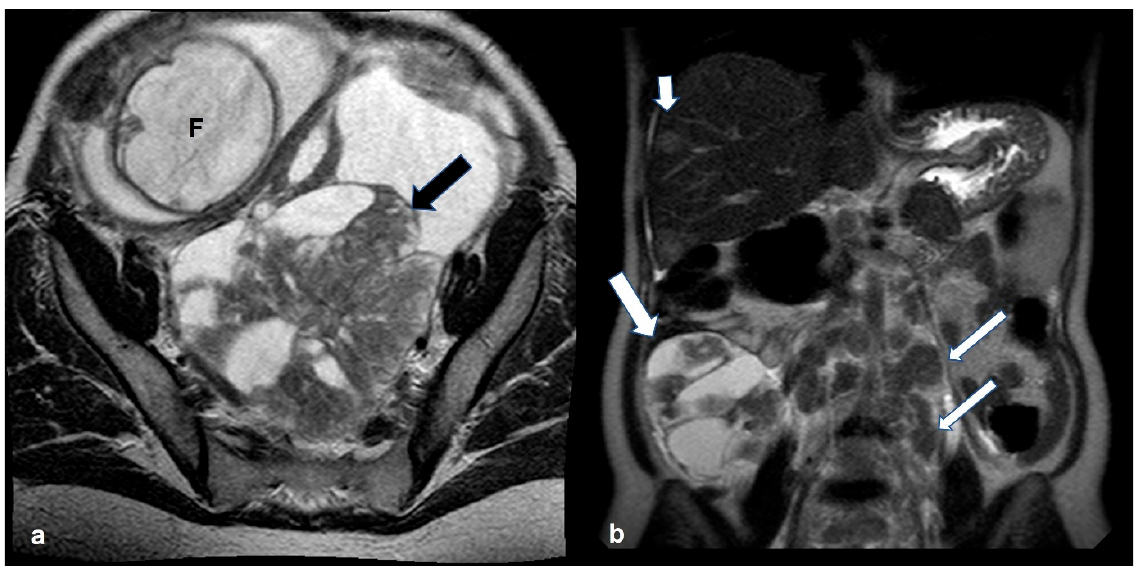
Figure 21. Bilateral high grade epithelial ovarian cancer in a 26 gestational week pregnant woman with twins. Axial T2 weighted image ( a ) shows a mixed cystic-solid left ovarian mass (black arrow). Coronal T2 weighted image ( b ) of the same patient shows a mixed cystic-solid mass in the contra- lateral ovary (thick white arrow). Shown also are enlarged left paraaortic lymph nodes (thin arrows) and hepatic metastases (short arrows). F: fetus.